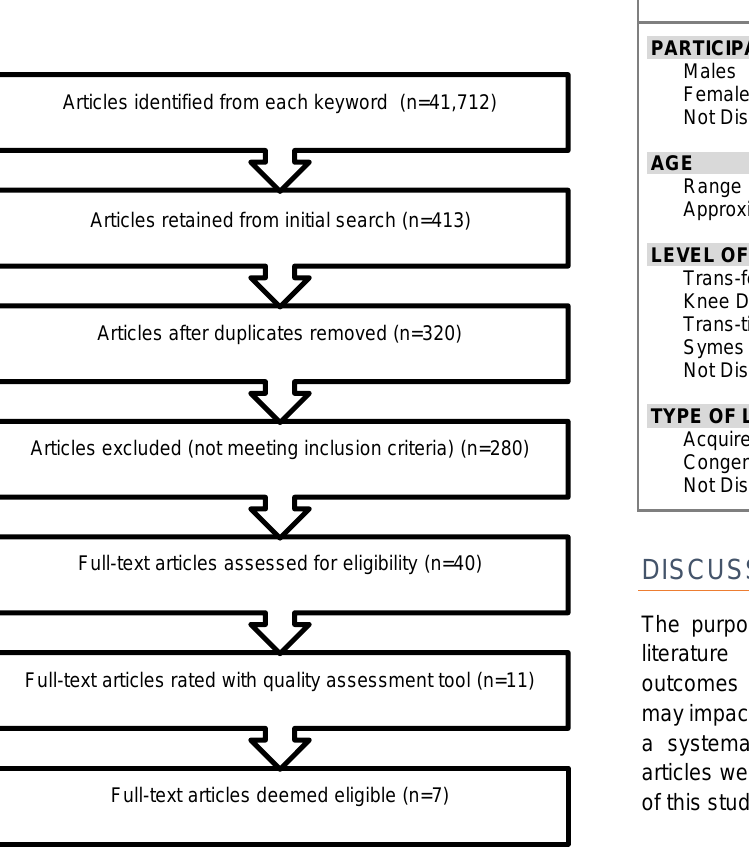
Figure 1 : Article eligibility flow chart.